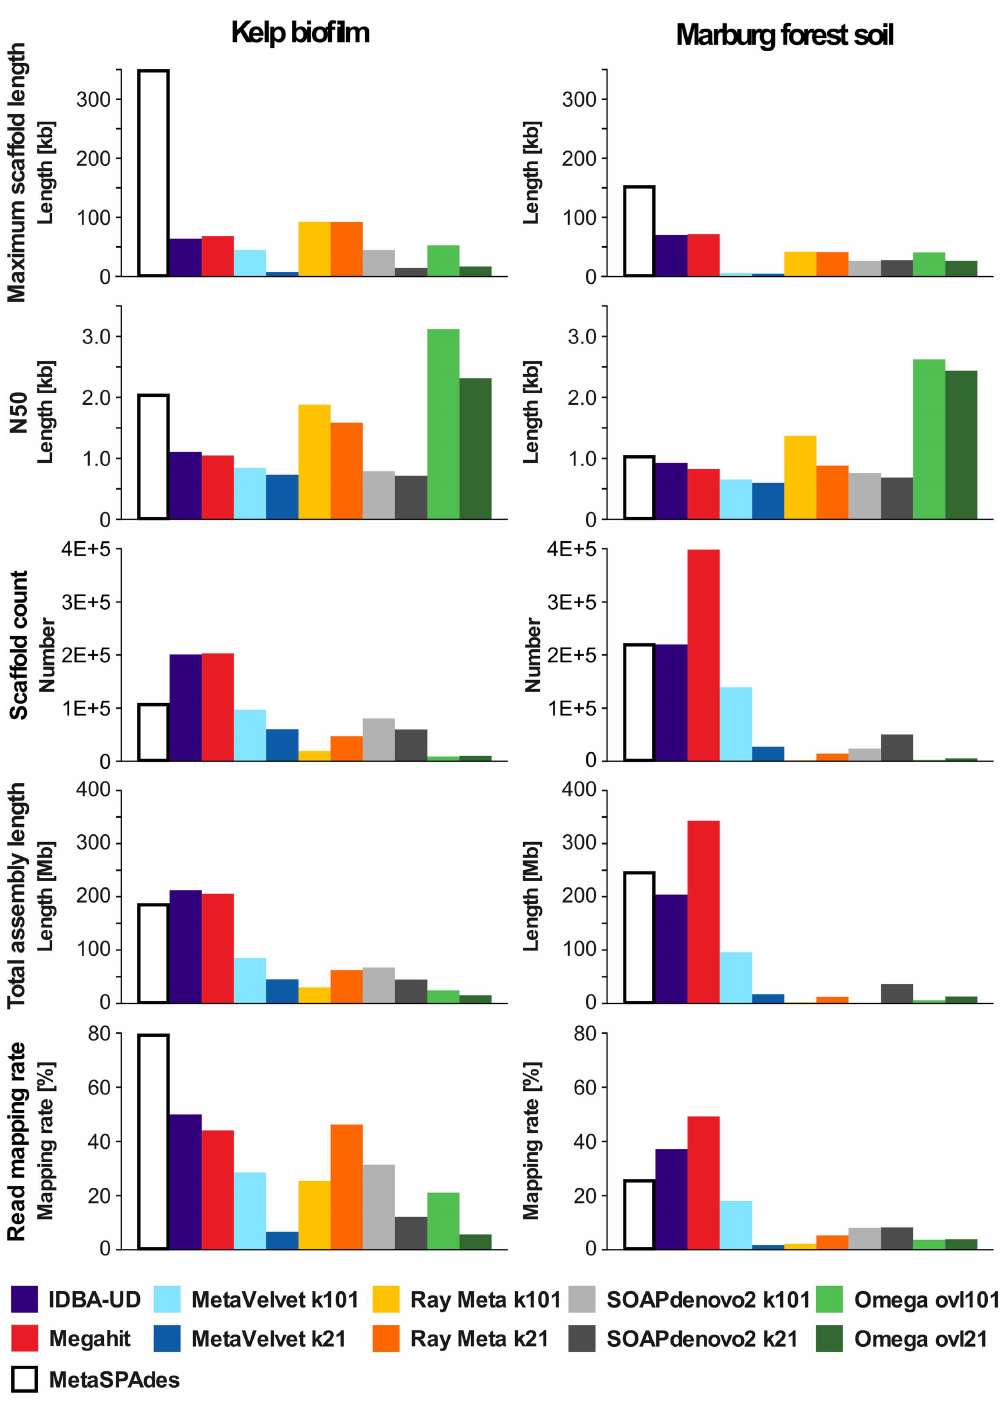
Fig 2. Comparison of individual assembly characteristics produced by different assemblers. Kelp biofilm (KBF) assembliesare shown on the left and Marburg forest soil (MFS) assemblies on the right. Assemblers utilizing singlek-mer lengthswere tested with two different values for k , 21 and 101. All statistics are based on scaffolds larger than 500 bp. The maximum scaffold length indicatesthe size of the single largest scaffold, while the N50 value represents a weightedaverageacross all scaffolds. The scaffold count represents the total number of scaffolds > 500bp.The total assembly lengthand the read mappingrates indicate how much of the metagenomic sequence information is represented in the assembly. Read mappingrates were determinedusing the short read mappingtool Bowtie2and quality-trimmed pairedend reads (for a completelist of assembly statistics, pleaserefer to S2 Table).